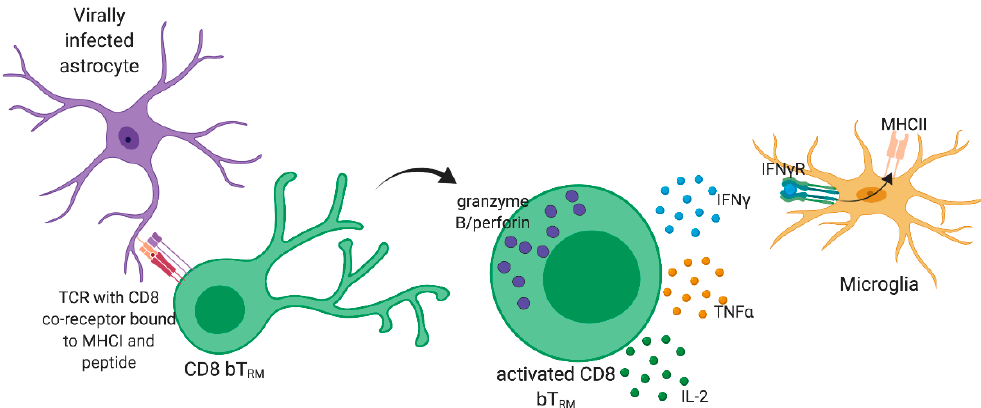
Figure 1. CD8 T RM have multiple effector functions. After stimulation by cognate antigen through their T cell receptors TCRs, CD8 T RM may become activated to produce cytotoxic granules such as granzyme B and perforin and/or cytokines such as IFN γ . These granules induce apoptosis in target cells, but this process may require additional help from cytokines. IFN γ is the most common cytokine produced by CD8 T RM , but CD8 T RM can also produce other cytokines, such as TNF α and IL-2. IFN γ has many functions in the brain, including increasing MHCII expression of microglia and other antigen presenting cells. The figure was created with BioRender.com.